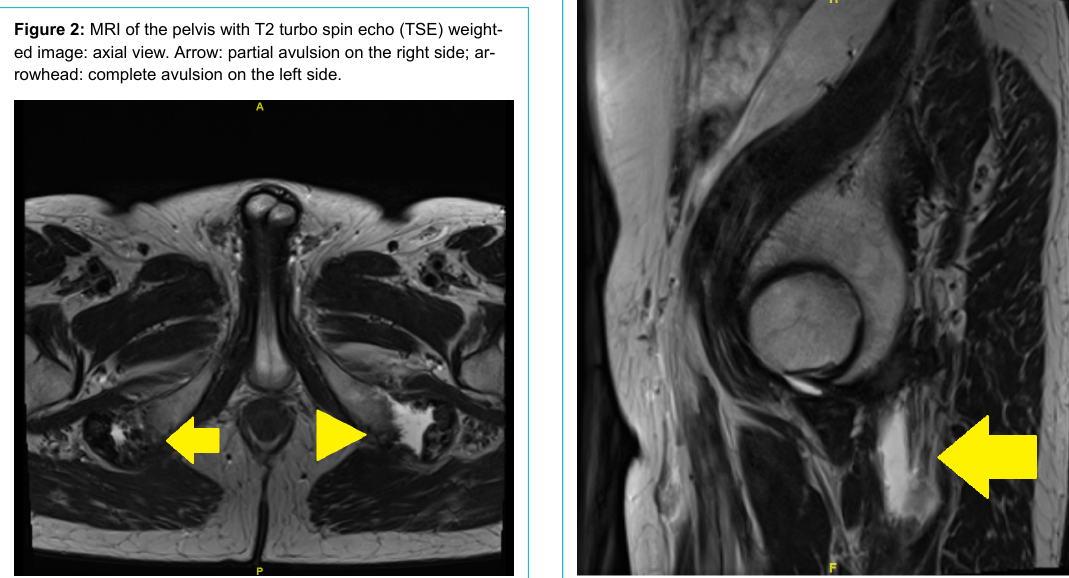
Figure 4: MRI of the pelvis with T2 turbo spin echo (TSE) images: sagittal view. Arrow: complete avulsion on the left